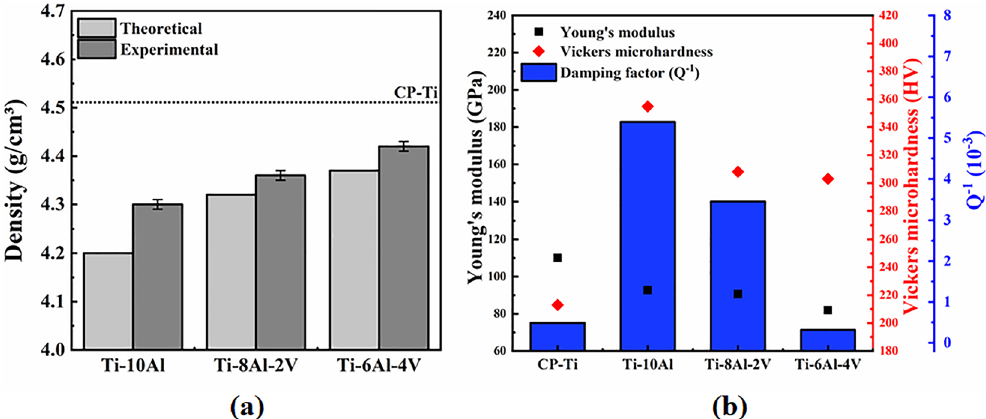
Figure 5. Selected properties: ( a ) density and ( b ) mechanical